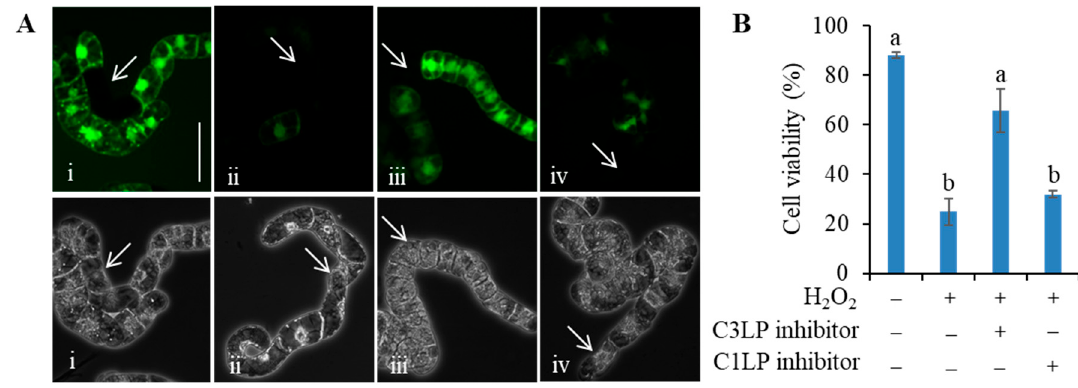
Figure 3. Effects of caspase inhibitors on the H 2 O 2 -induced cell death. Four-d cultured BY-2 cells were treated, as in Figure 1, with 1 mM H 2 O 2 in the presence or absence of an inhibitor. The cells were harvested after 5-h incubation, and FDA-stained cells were counted as living cells. ( A ) Typical fluorescence images (top) and phase contrast images (bottom) of the same field: (i) untreated cells as control, (ii) 1 mM H 2 O 2 , (iii) 1 mM H 2 O 2 + 20 µM C3LP inhibitor, and (iv) 1 mM H 2 O 2 + 20 µM C1LP inhibitor (top). White arrows indicate dead cells. Bar = 50 µm. ( B ) Percentage of living cells. A total of 400 cells were observed in each treatment. Mean of 3 runs ± SEM. Different letters represent significantly different values ( p < 0.05 on Tukey test).